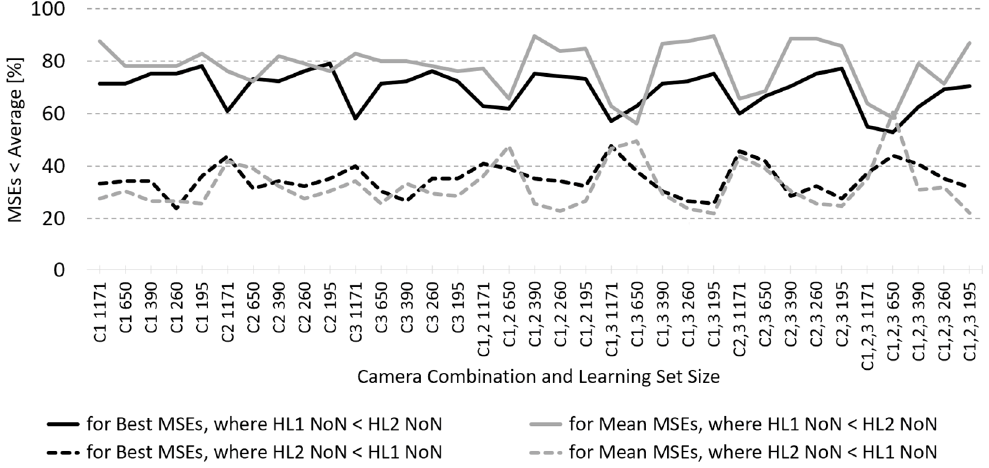
Figure 4. Percentage of best and mean test set MSEs that are lower (better) than their averages in LM-trained ANNs, according to the number of neurons (NoN) in the first and the second hidden layers (HL1, HL2).